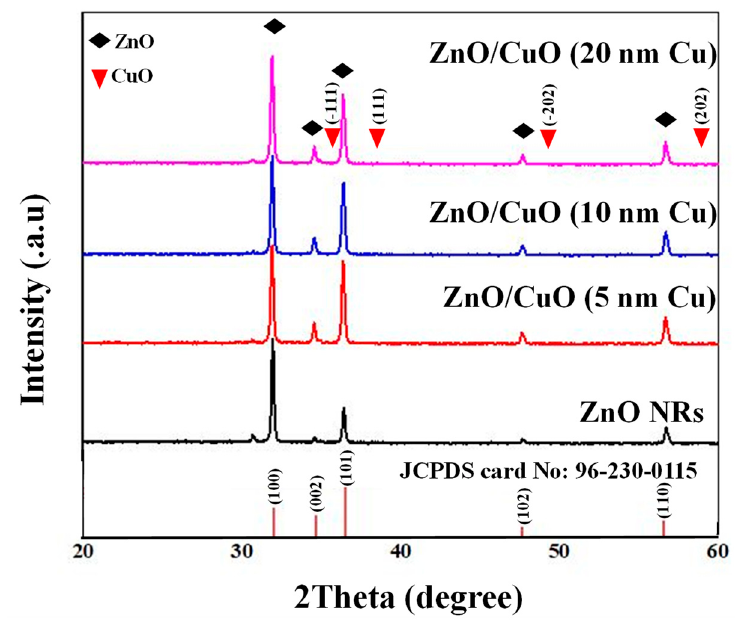
Figure 5. XRD patterns of pristine and CuO-decorated ZnO NRs.